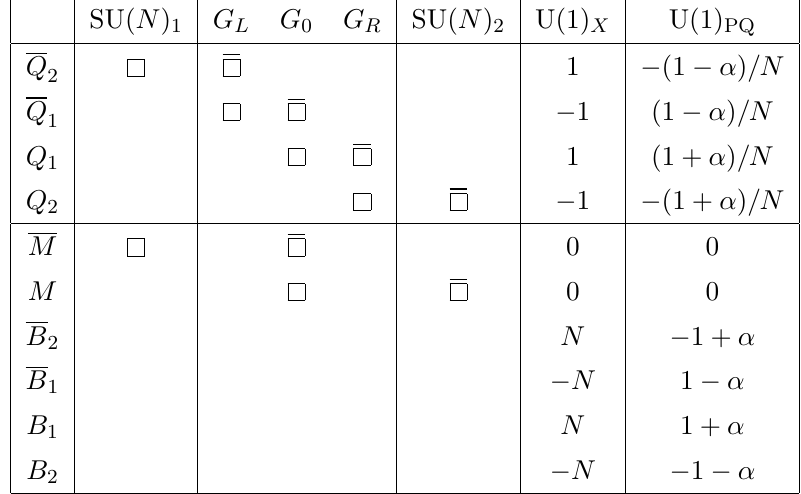
SU( N ) SM SU( N ) R U(1) X and global SU( N ) 1 (cid:2) (cid:2) (cid:2) SU(2) L U(1) Y is a subgroup of G 0 . (cid:2) (cid:2)